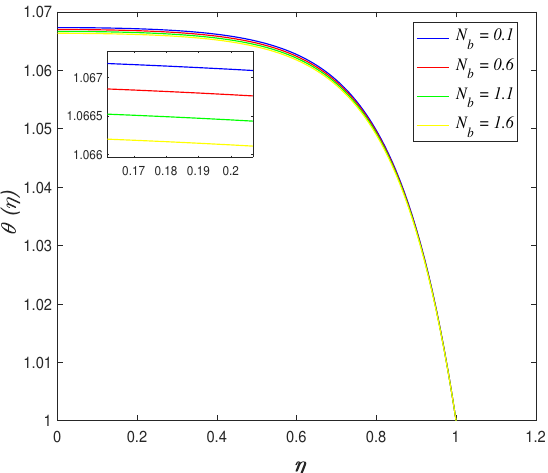
Figure 19. Impact of N b on temperature.